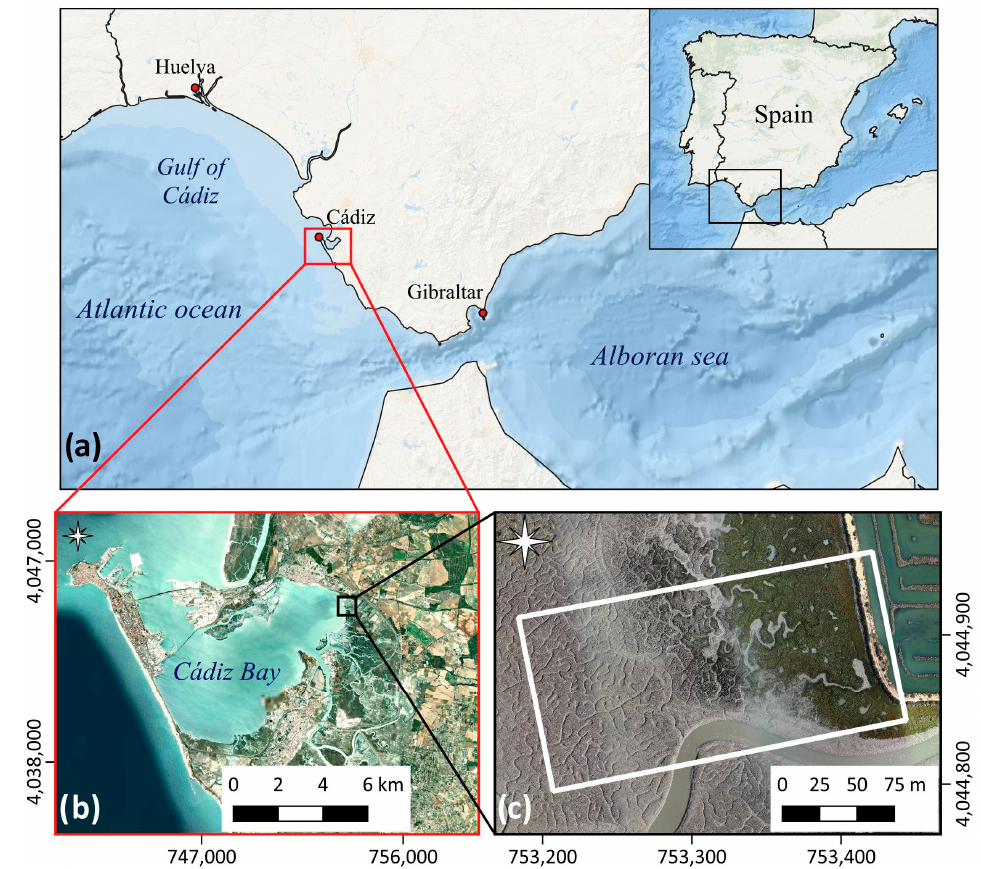
Figure 1. Location of the Cadiz Bay: regional context ( a ) and detail of the study area ( b , c ) The white rectangle in picture c represents the flight area for the UAV-HS survey. Coordinates are expressed in ETRS89/UTM zone 29N reference system (EPSG:25829).